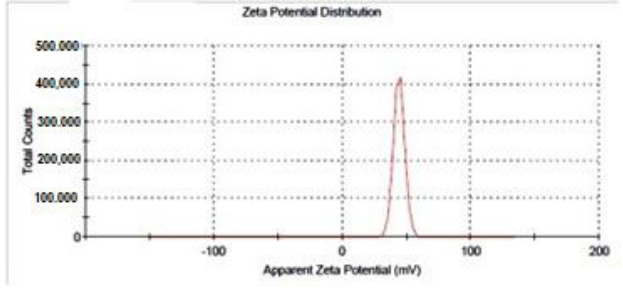
Figure 3. Apparent zeta potential of WCSNPs assessed by Malvern Zetasizer ZS.